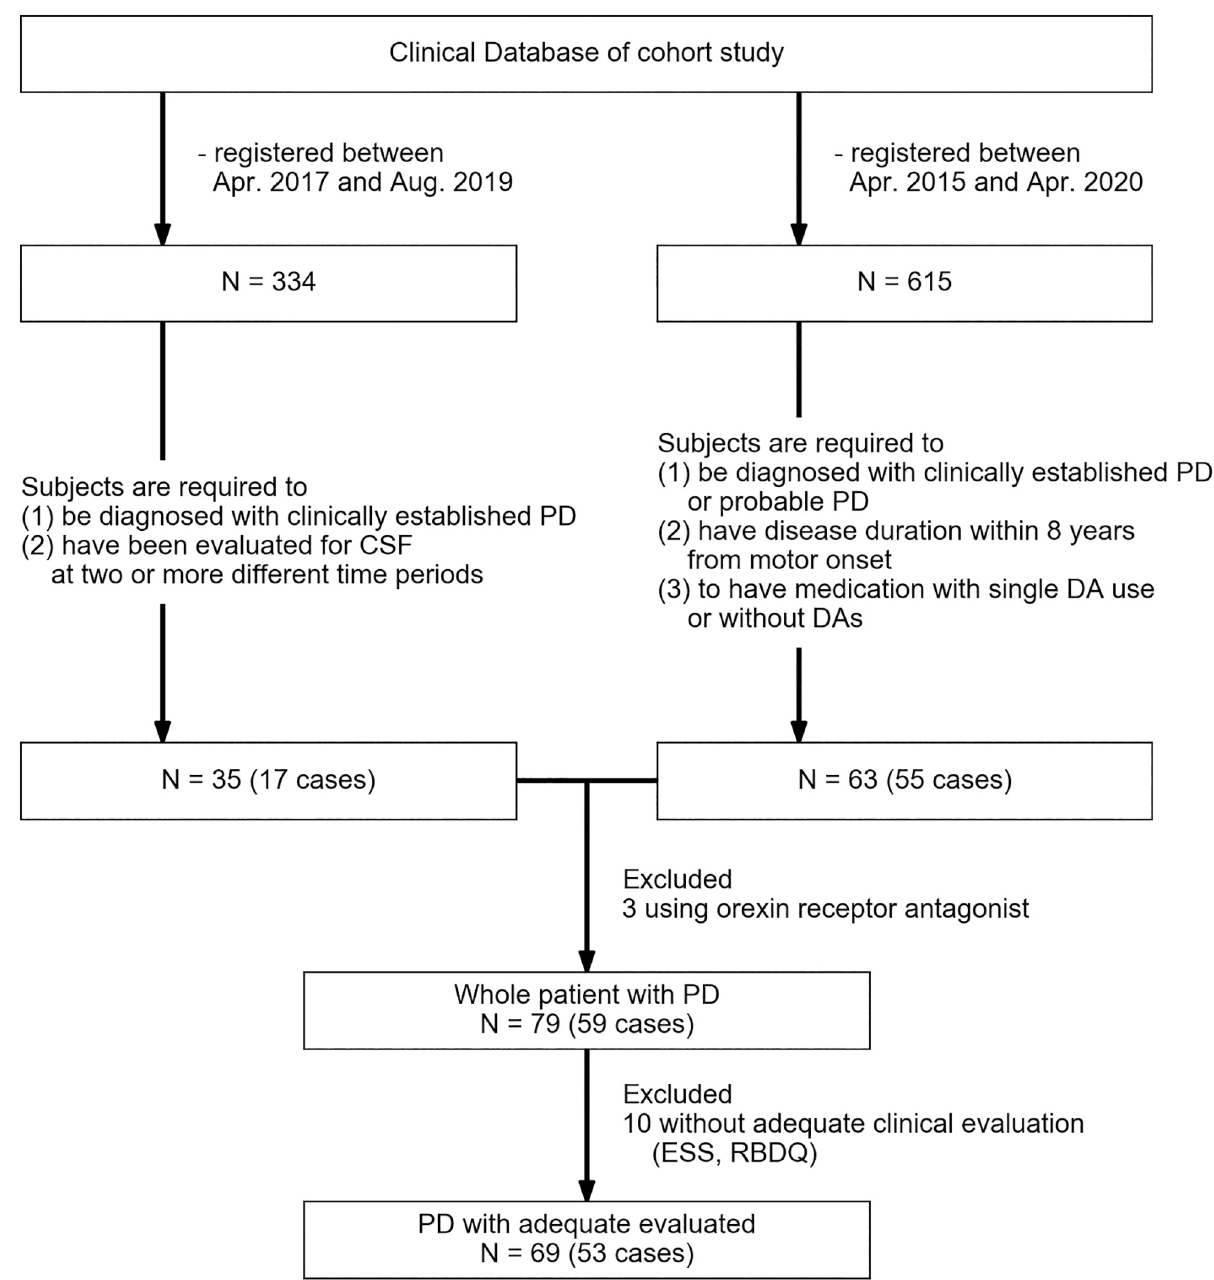
Fig 1. Flowchart illustrating the study design. Confirmatory or probable PD were diagnosed according to the Movement Disorder Society Diagnostic Criteria for PD. N, number of samples; PD, Parkinson’s disease; RBDQ, Rapid Eye Movement Sleep Behavior Disorder Questionnaire; DA, dopamine